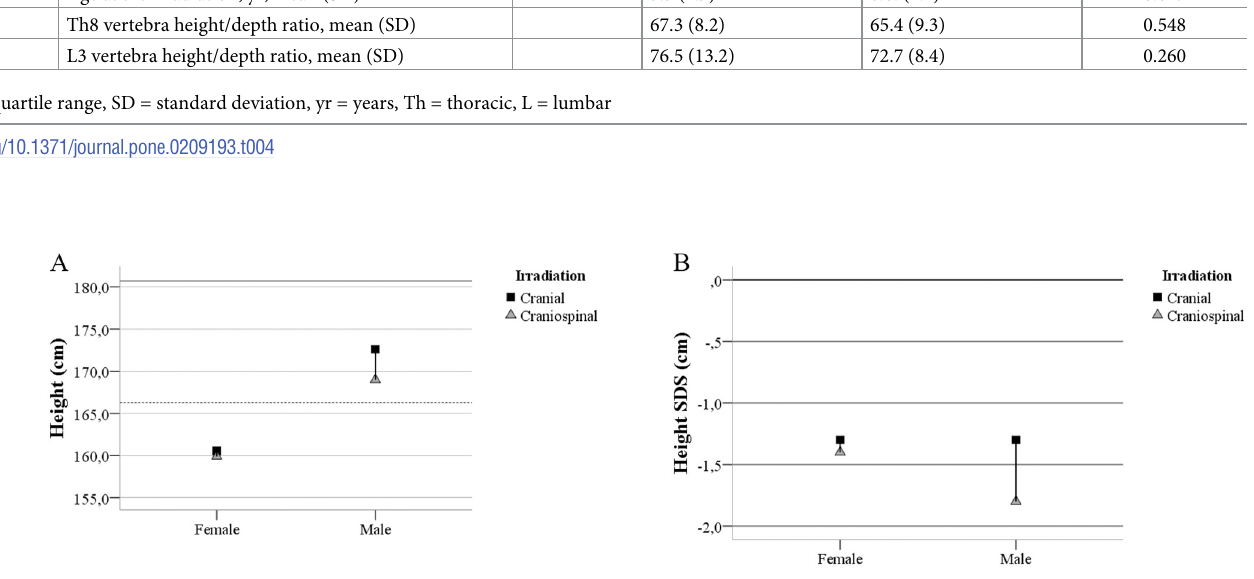
Fig 4. Comparison of the height of the study subjects with the general Finnish population. A: Height (cm) by gender, adult male height reference (solid line), adult female height reference (dotted line). B: Height standard deviation score (SDS) by gender with 0 SDS (dashed line). Cranial irradiation (solid square), craniospinal irradiation (triangle).